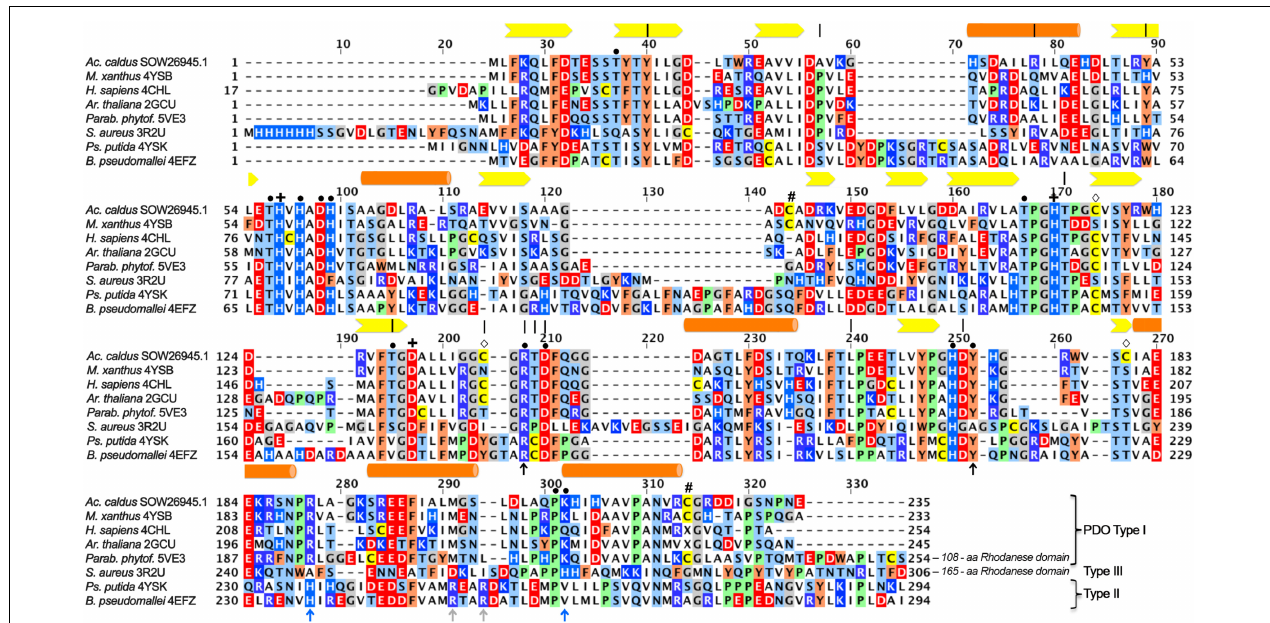
FIGURE 1 | Multiple alignment of iron-containing persulfide dioxygenase (PDO) sequences. Sequences were downloaded from GenBank, aligned using the MAFFT server and manually corrected with respect to the 3D structures (GenBank/PDB accession in species names). Type I, Type II, and Type III enzymes were grouped according to Xia et al. (2017). Bars, alpha helices; arrows: beta sheets; | , residues correlated with ETHE according to Refs. (Tiranti et al., 2004, 2006; Jung et al., 2016); + , iron ligands; # , cysteine residues at the surface of the Mx PDO (Sattler et al., 2015); ♦ , other cysteine residues of the Ac PDO; • secondary coordination sphere and hydrogen bonding network residues; black ↑ , GSH-binding residues in all PDOs; blue ↑ , GSH-binding residues in all PDOs; gray ↑ , GSH-binding residues in Type II